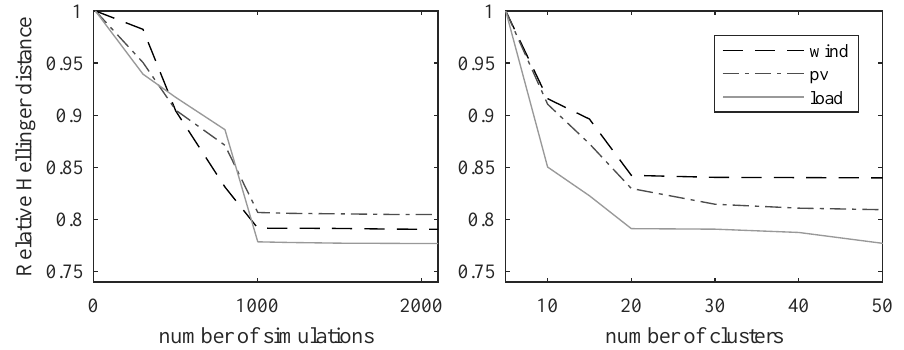
Figure 3. Added value of more simulations ( left ) and more clusters ( right ) compared to empirical distribution by calculating the relative Hellinger distance (Hellinger distance normalized to the first measure) according to